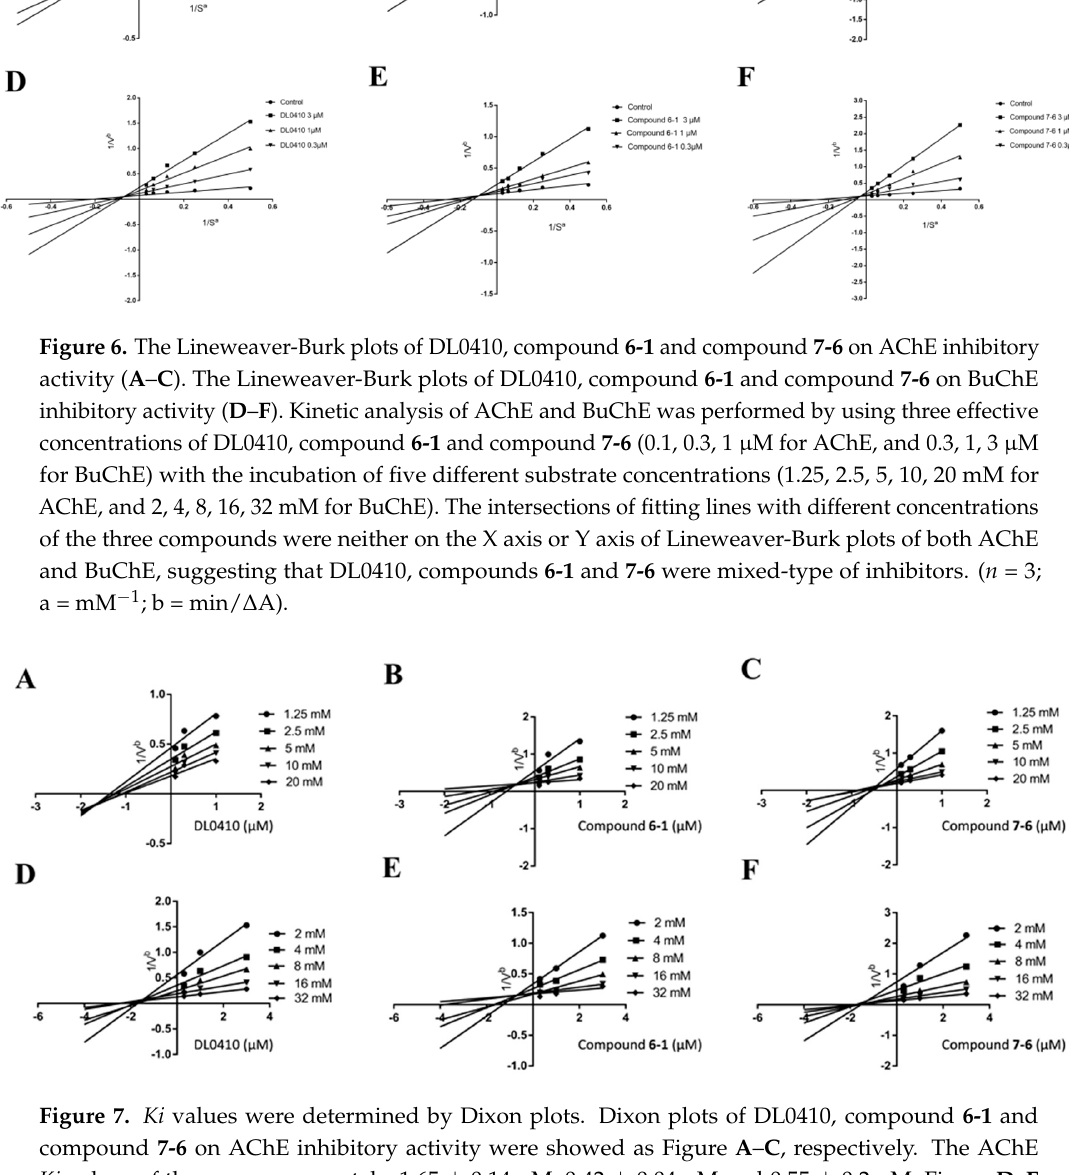
Figure 7. Ki values were determined by Dixon plots. Dixon plots of DL0410, compound 6-1 and compound 7-6 on AChE inhibitory activity were showed as Figure A – C , respectively. The AChE Ki values of them were, separately, 1.65 ± 0.14 µ M, 0.42 ± 0.04 µ M and 0.55 ± 0.2 µ M. Figure D – F presented the Dixon plots of DL0410, compound 6-1 and compound 7-6 on BuChE inhibitory activity, respectively. The BuChE Ki values of them were, separately, 1.81 ± 0.08 µ M, 0.74 ± 0.16 µ M and 1.63 ± 0.18 µ M. ( n = 3; b = min/ ∆